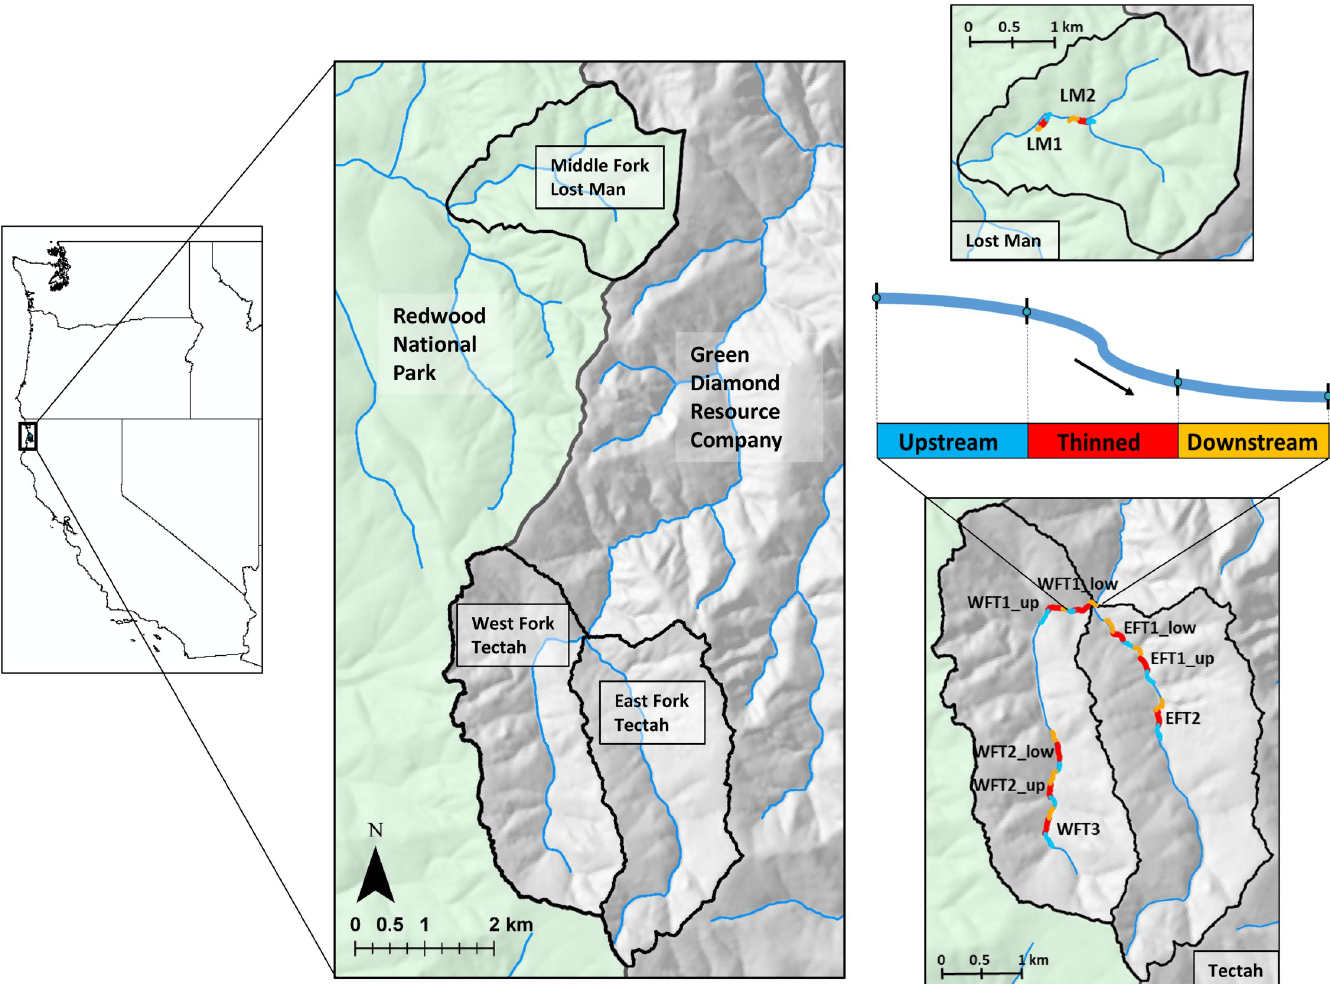
Fig 1. Study watersheds map. Map of study watersheds in northern California second-growth redwood forests. Data were collected in upstream reference, thinned, and downstream reaches, which were replicated at 10 total sites distributed across these three watersheds. Temperature sensors were deployed at the top and bottom of each reach indicated by blue points in illustration of study reaches. See Table 1 for characteristics of study sites. Map by David A. Roon in ArcGIS Pro (ESRI, Redlands, CA USA) using data collected by the authors and publicly-available GIS shapefiles from the California State Geoportal: https://gis.data.ca.gov/ [41,